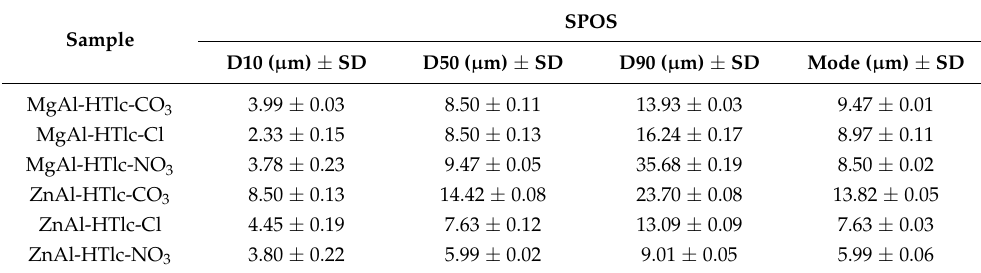
Table 2. Dimensional values of the different HTlcs by SPOS analysis ( n = 3; ± SD).